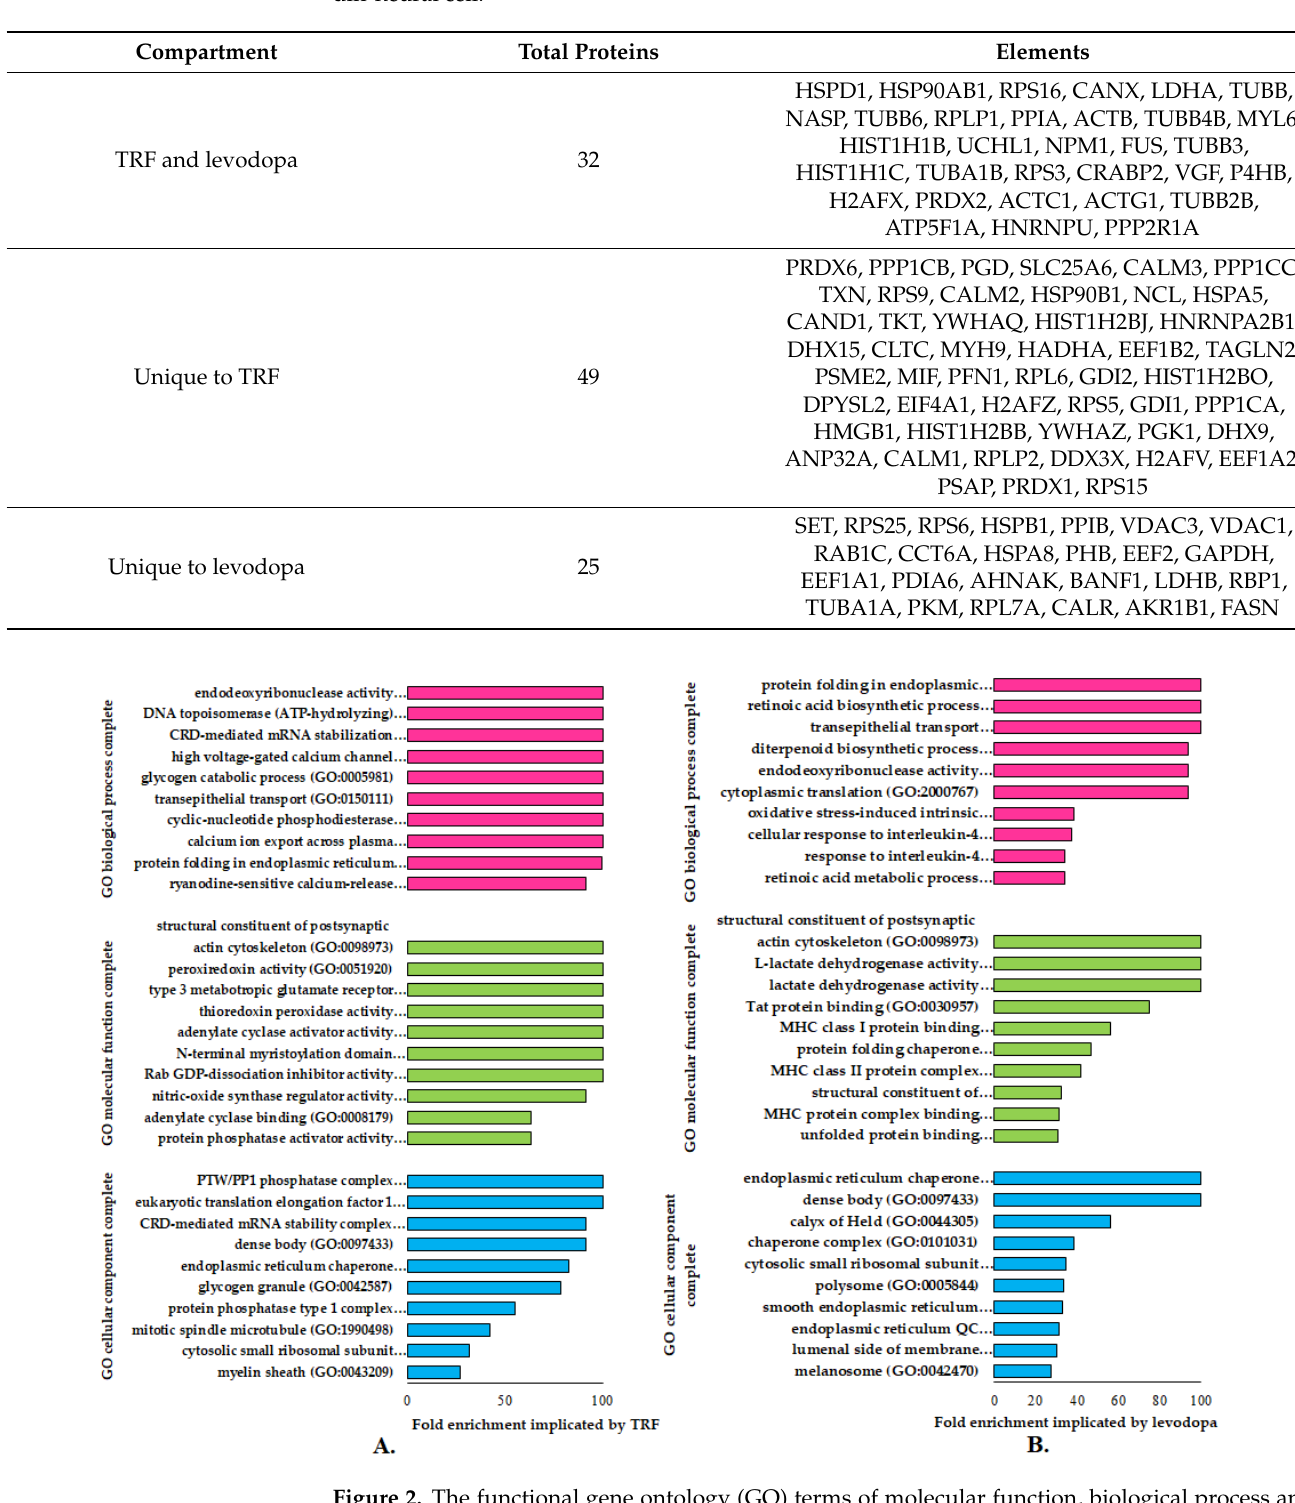
Figure 2. The functional gene ontology (GO) terms of molecular function, biological process and cellular component using PANTHER (version 16) database on differentially regulated proteins ( p < 0.05) in ( A ) TRF and ( B ) levodopa treatments on diff-neural cells. The horizontal coordinate (x-axis) represents the logarithmic transformation at the base of 10 of the raw p -value, and the vertical (Y-axis) displays the GO term classifications.